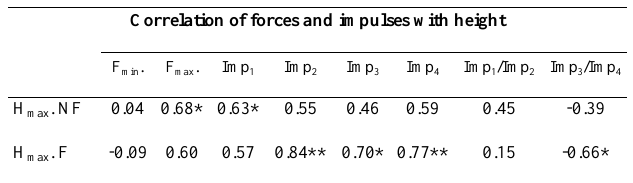
Table 3. The correlation coefficients between the maximum height reached in CMJ (H ) before the fatigue protocol (NF) and in presence of max muscular fatigue (F) and the kinetic values considered in the study. The asterisks (*) and (**) indicate the existence of significant correlations with p <0.05 and p <0.01 respectively.